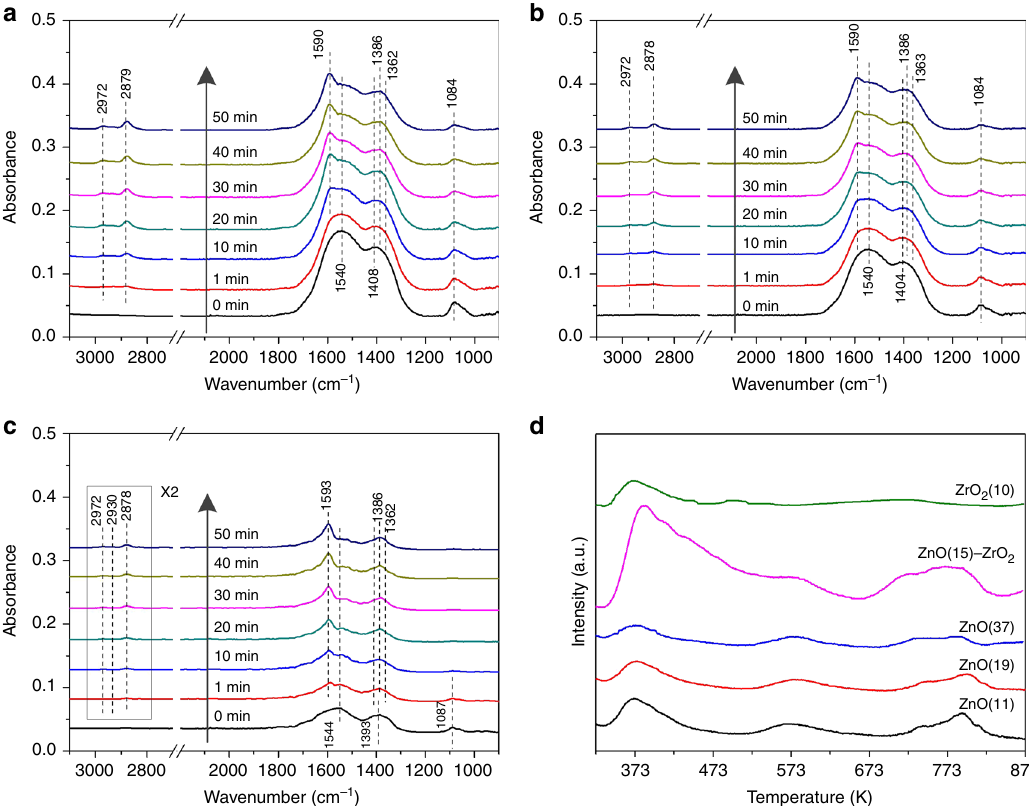
Fig. 4 Characterization of the surface species on the ZnO – ZrO 2 samples with different particles size of ZnO. In situ DRIFT spectra of a ZnO(15) – ZrO 2 , b ZnO(21) – ZrO 2 , and c ZnO(42) – ZrO 2 at 493 K after switching the feed gas from CO 2 to H 2 with a fl ow rate of 40 mL/min under atmosphere pressure. d CO 2 -TPD patterns of ZnO(15) – ZrO 2 , pure ZnO with different particle sizes and pure ZrO 2 with an average particle size of 10